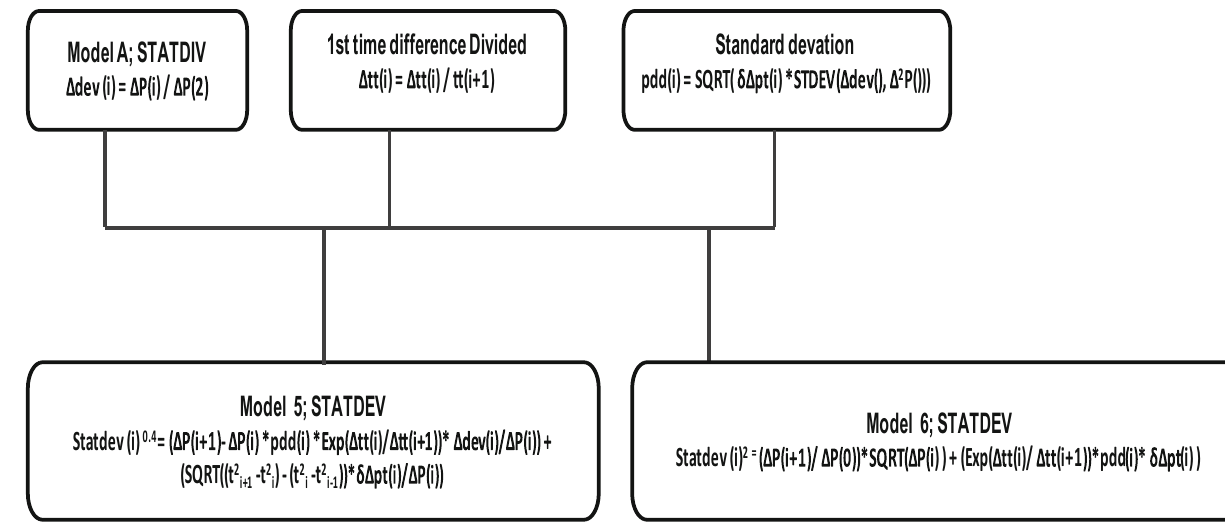
Fig. 18 Statistical models for flow regime